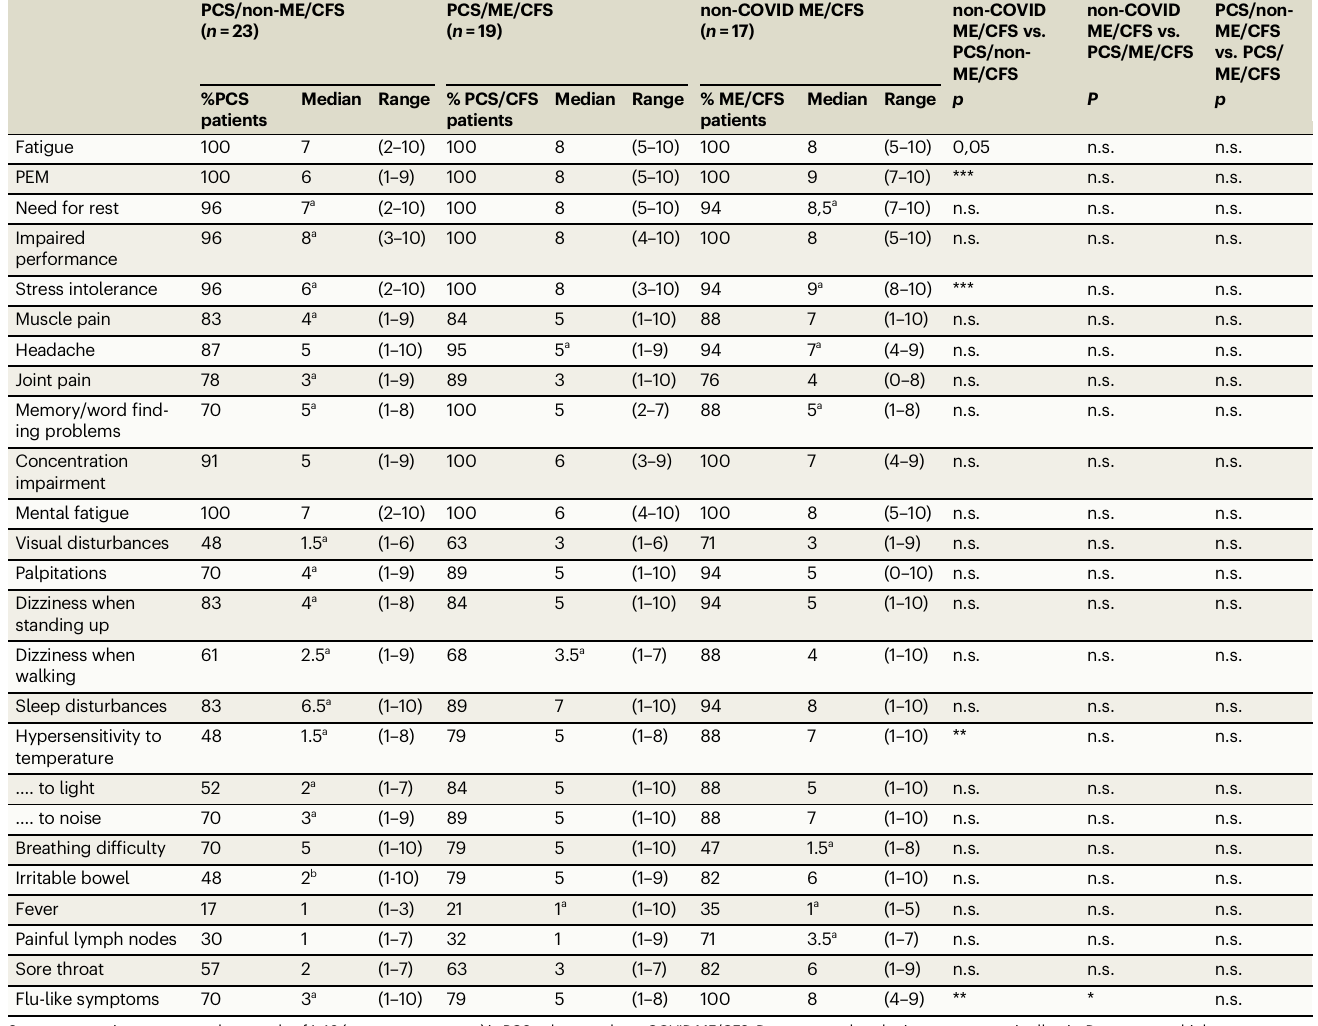
Table 2 | Frequency and severity of